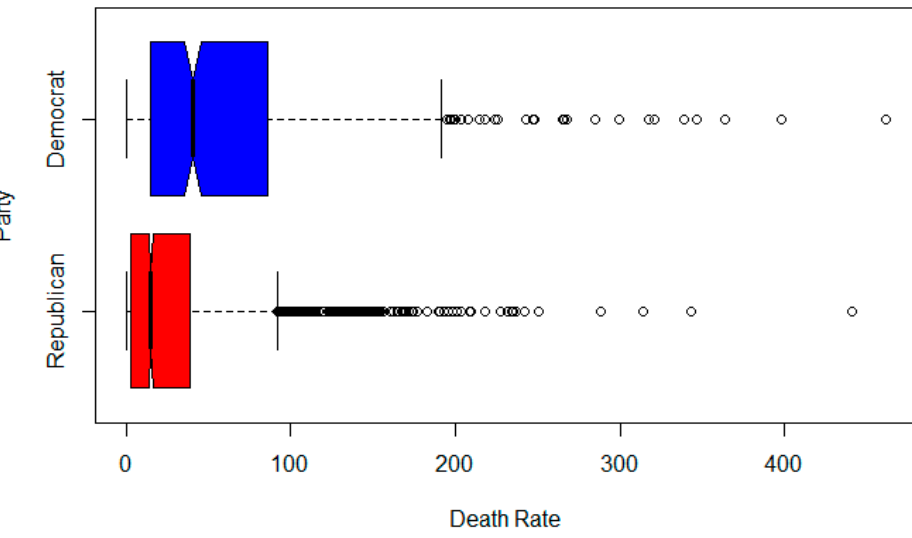
Figure 1. Boxplots of Republican versus Democratic county death rates per 100,000.